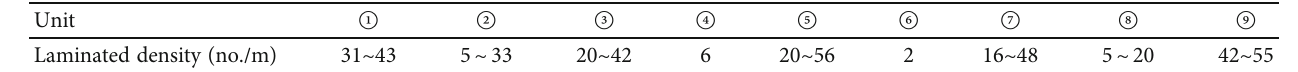
Table 1: Laminated density classi fi ed standard of Y1 units. Unit